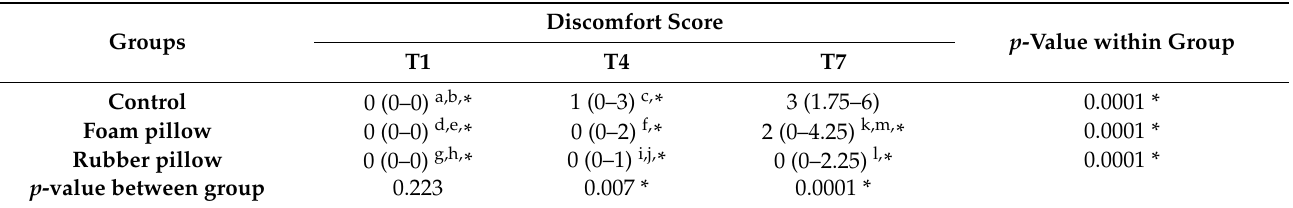
Table 2. Comparison of discomfort scores in the back region within the group and between the experimental groups.